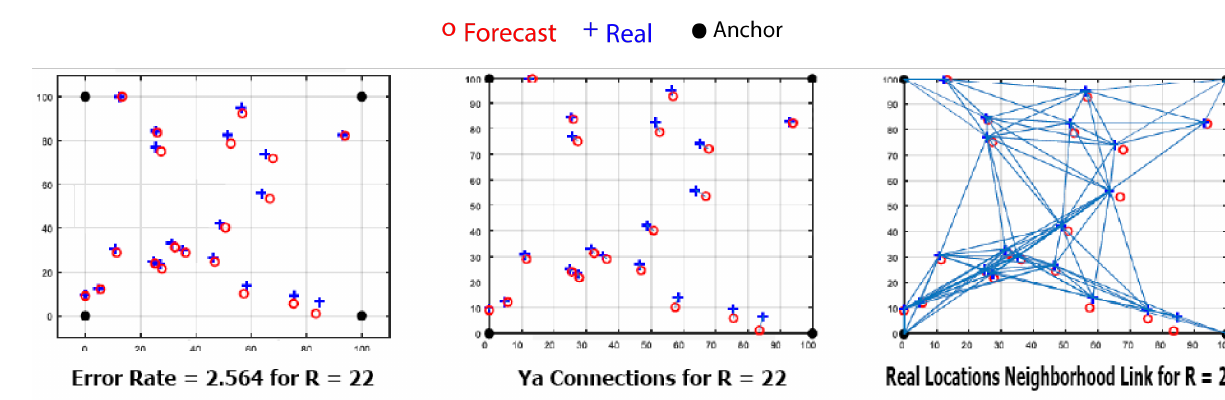
Figure 20. Obtaining Error Rate for Bat Algorithm.